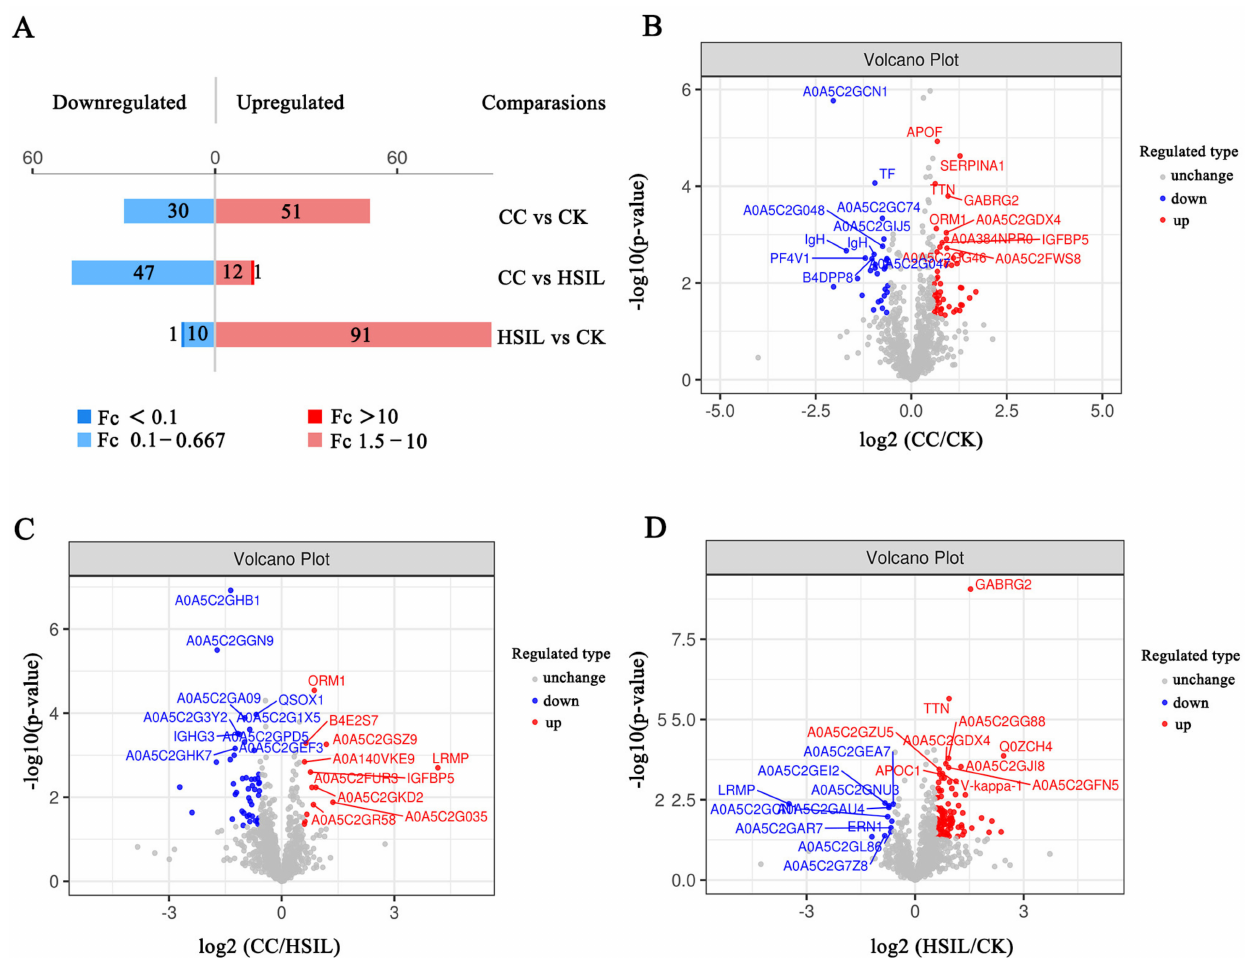
Figure 3. Expression of differential proteins (DEPs). ( A ) Bar chart of protein quantitative difference results; ( B ) Volcano plot of differentially expressed proteins between CC and CK groups; ( C ) Vol- cano plot of differentially expressed proteins between CC and HSIL groups; ( D ) Volcano plot of differentially expressed proteins between HSIL and CK